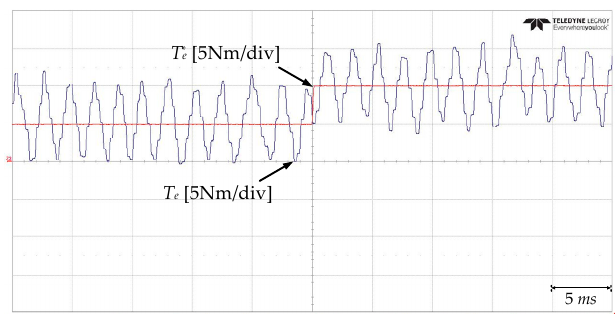
Figure 17. Experimental zoomed result of the transient-state operation neutral-point balancing at 150 r/min.